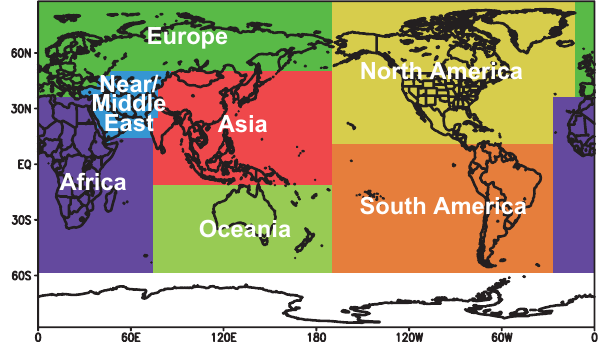
Fig. 1. Definition of regions in this